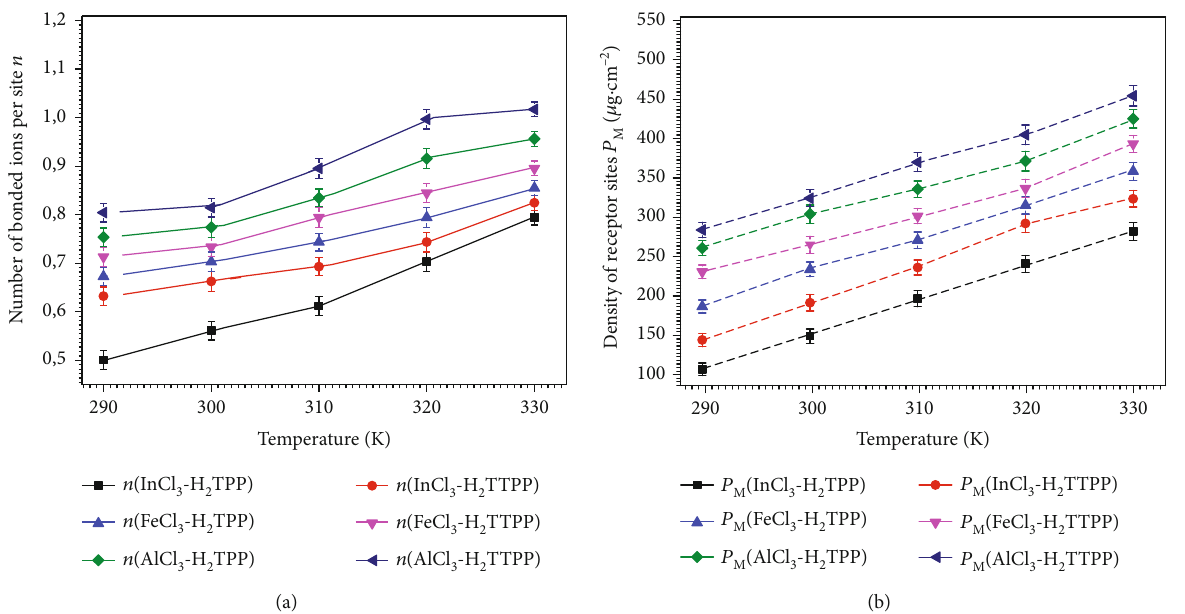
Figure 6: Evolutions of the two steric parameters as a function of temperature: (a) evolution of the number of bonded ions per site n and (b) variation of the density of receptor porphyrin sites P